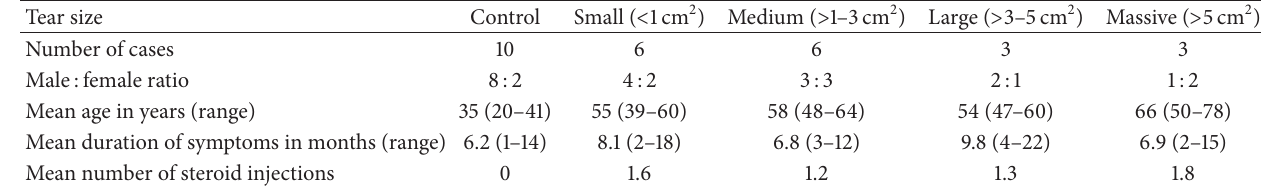
Figure 1: IL-21R message and protein in human tendinopathy. (a) The levels of mRNA ( 2 −ΔΔ CT ) for IL-21R were determined by real-time PCR in torn tendon and early tendinopathy samples. Data are shown as the mean fold change ± SD of triplicate samples compared to control samples corrected to GAPDH and are representative of experiments using 12 individual donors of tendon tissue ( ∗ 𝑃 < 0.05 , ∗∗ 𝑃 < 0.01 ). (b) Semiquantitative scoring of IL-21R protein expression in tendon samples. Graphs illustrate relative expression of corresponding proteins in human tendon samples. Histological scoring system, 0 = no staining, 1 ≤ 10% cells positive, 2 = 10–20% cells positive, grade 3 ≥ 20% cells positive. Data displayed as mean ± SEM, 𝑛 = 12 for supraspinatus and matched subscapularis, 𝑛 = 10 for control group. ( ∗ 𝑃 < 0.05 , ∗∗ 𝑃 < 0.01 ). Table 1: Patient demographics and rotator cuff tear